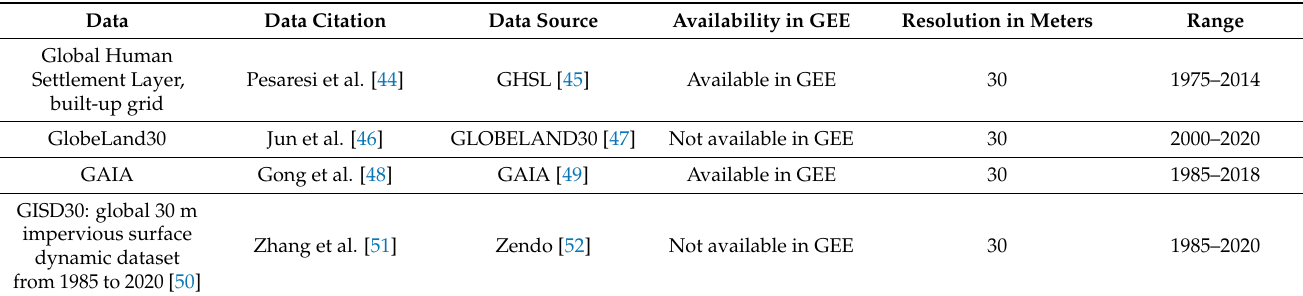
Table 1. List of dataset characteristics for urban